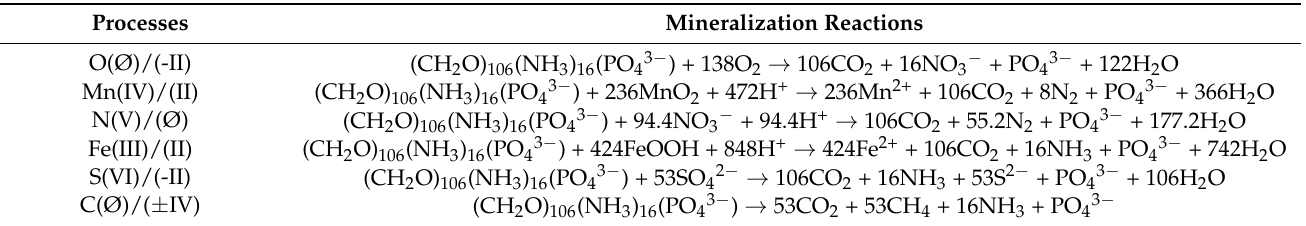
Table 1. Organic matter mineralization reactions (modified from [12]). Mineralization